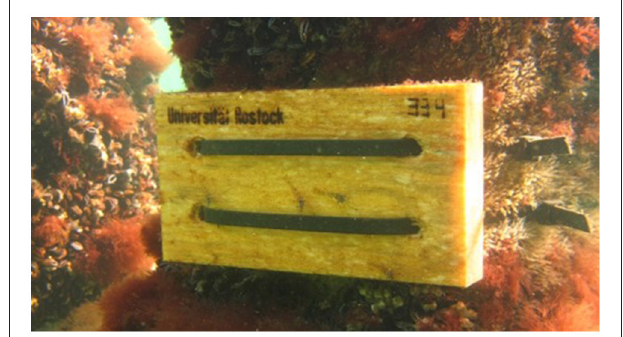
FIGURE 2 | Larval trap: Representative pinewood panel attached to a groin in the shallow water of the southern Baltic Sea coast.